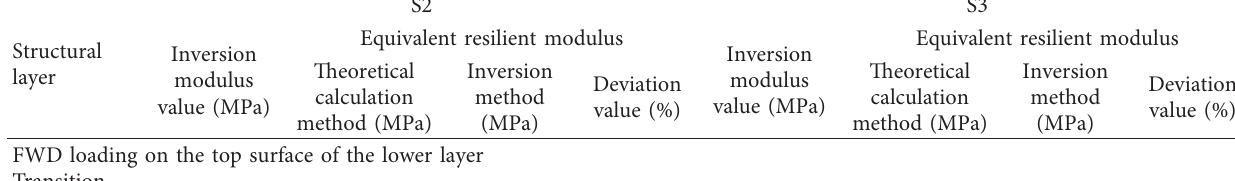
FWD loading on the top surface of the lower